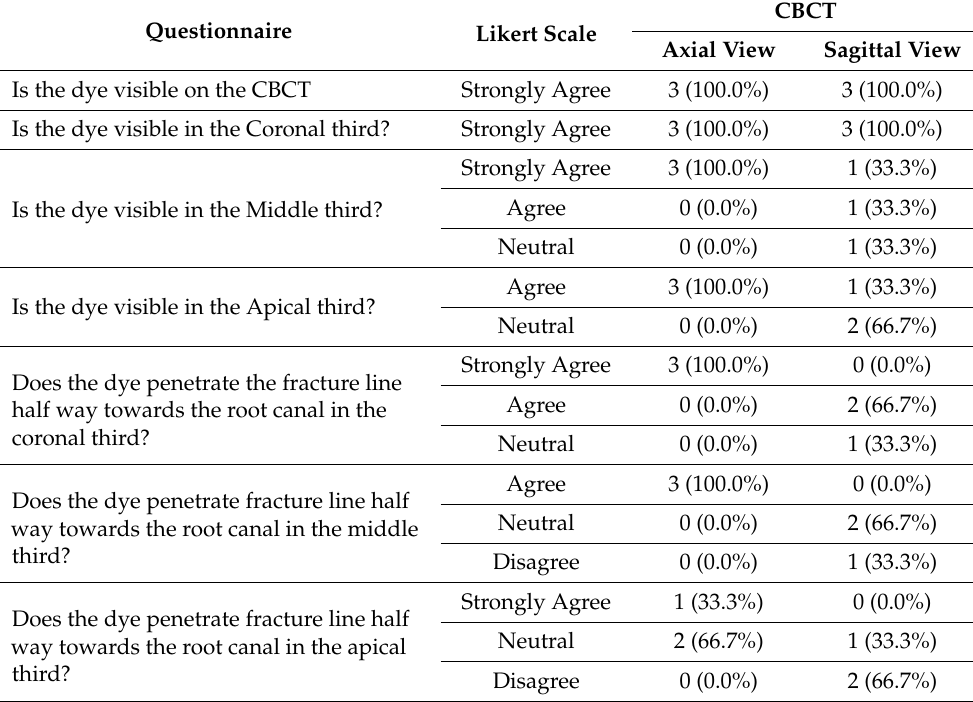
Table 3. Percentages of means of responses based on CBCT for experimental group (n = 24).